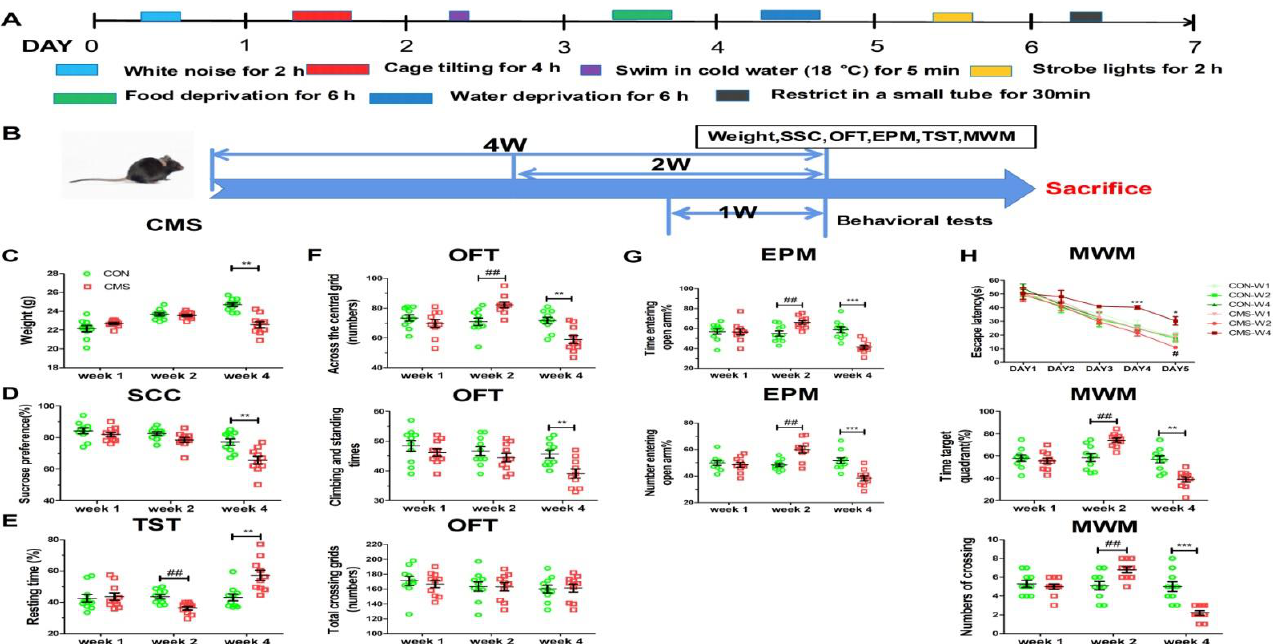
Figure 1. The behavioral adaptation and the improved spatial memory in C57BL/6J mice by a moderate duration of stress. ( A ) The detailed CMS procedure of 3-month-old C57BL/6J mice for each day. ( B ) The time schedule for experimental procedures in C57BL/6J mice. ( C ) Body-weight changes in the one-, two-, four-week CMS groups and controls. ( D ) The percentages of sucrose preference in mice undergoing one, two, and four weeks of CMS, respectively. ( E ) The percentage of resting time of 3-month-old mice during the 6 min test. ( F ) The numbers of crossings over the central grid, climbing and standing, total movement for all groups in OFT. ( G ) The percentage of time and numbers of entering into the open arms for the 3-month-old mice in EPM. ( H ) Escape latency in all mice for the first five days in MWM. The percentage of time spent in target quadrant and the numbers of crossing over the former platform position on the sixth day of MWM. N = 10 per group, each sample was not duplicated, expressed as mean ± SEM. * p < 0.05, ** p < 0.01, *** p < 0.001, 4-week CMS vs. 4-week CON; ## p < 0.01, 2-week CMS vs. 2-week CON.